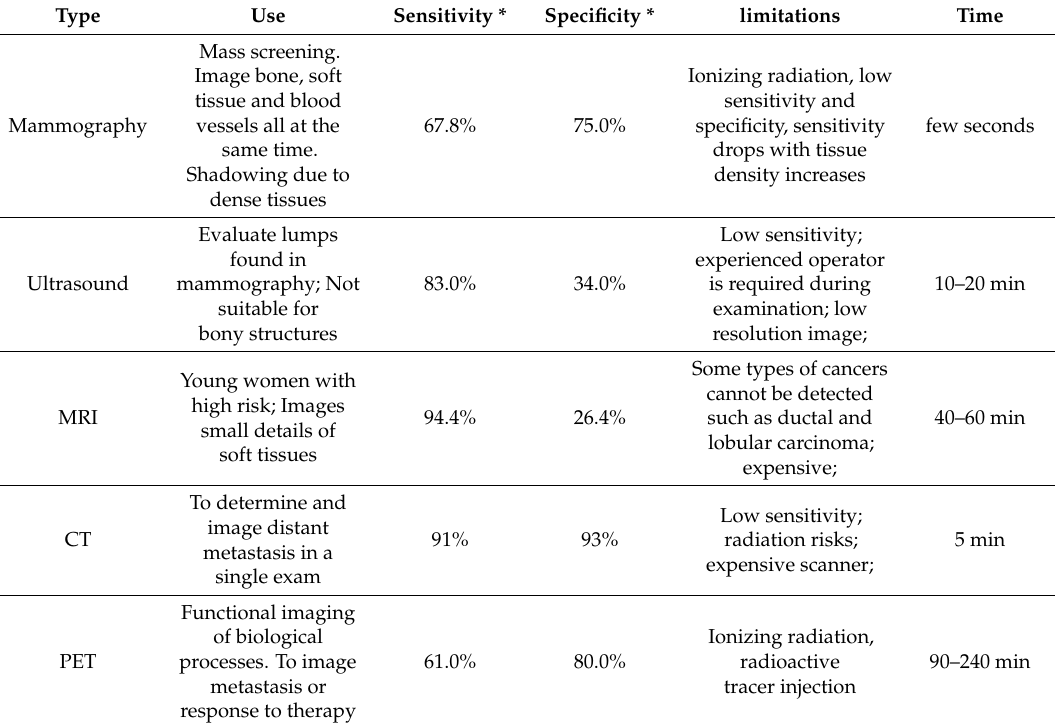
Table 1. Conventional breast screening methods and their